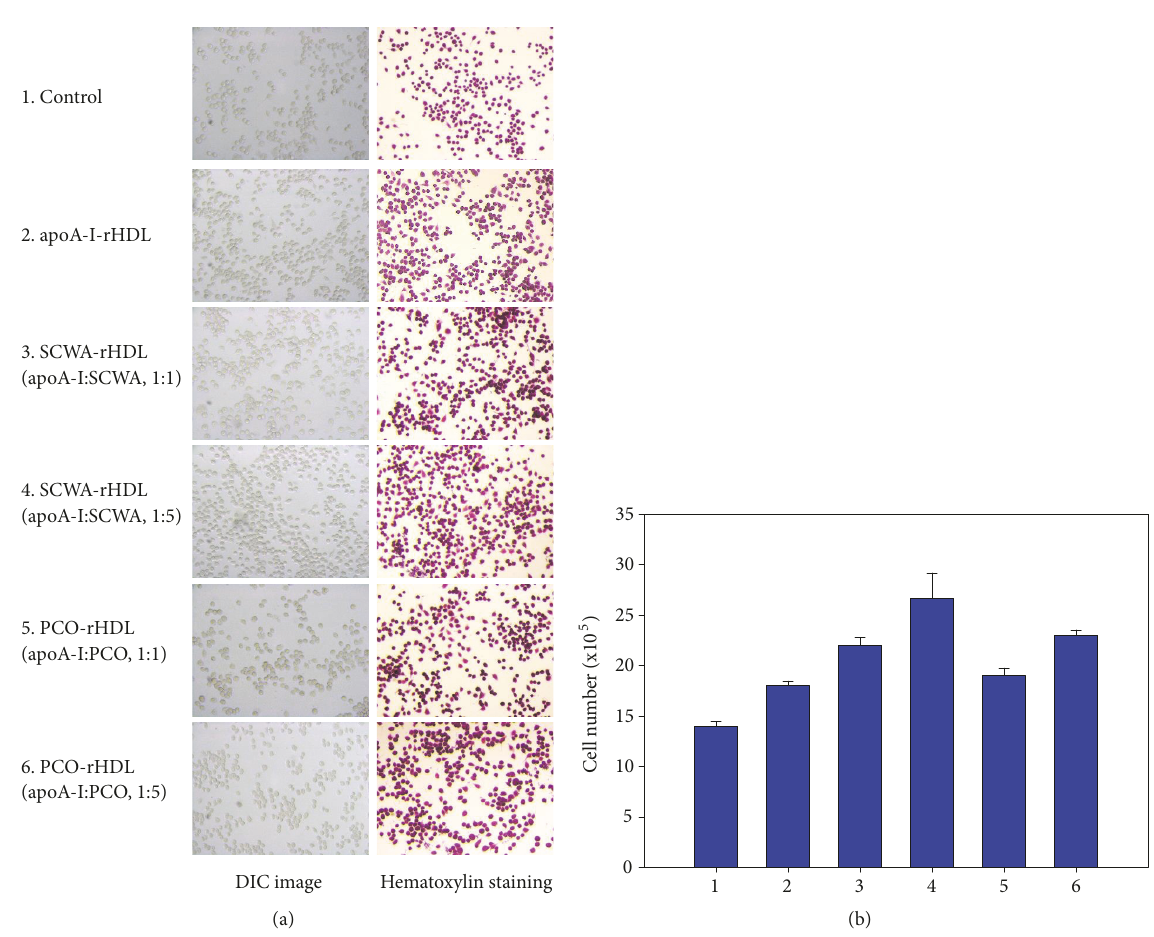
Figure 5: Enhancement of cell growth by rHDL containing SCWA and PCO in brain glial (BV-2) cells. Cell nucleus was visualized by hematoxylin staining in the presence of SCWA or PCO in rHDL. Photo 1, control; photo 2, apoA-I- rHDL; photo 3, SCWA-rHDL (1:1); photo 4, SCWA-rHDL (1:5); photo 5, PCO-rHDL (1:1); photo 6, PCO-rHDL